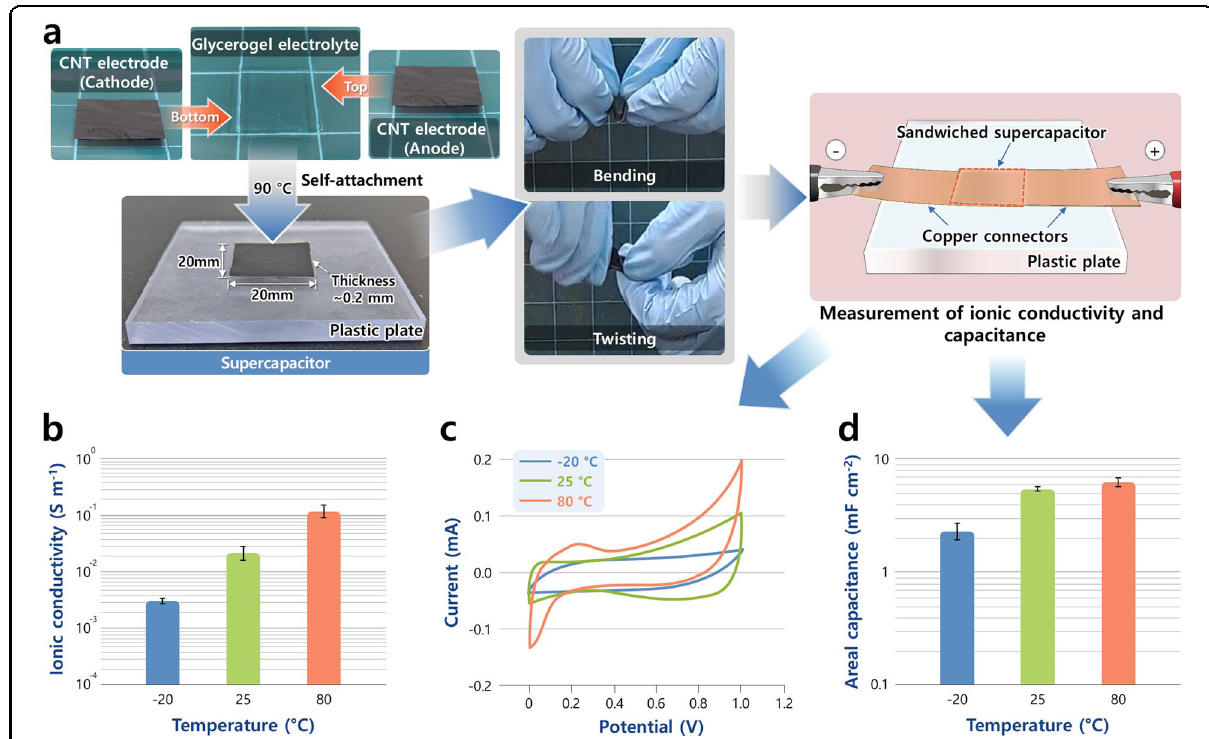
Fig. 6 GG-based fl exible electrolyte and supercapacitor. a Fabrication and characterization of the fl exible PVA-GG-electrolyte-based supercapacitor. b Ionic conductivities of the PVA GG electrolyte at different temperatures. c Cyclic voltammograms recorded at a scan rate of 1 mV s − 1 . d Calculated areal capacitance of the supercapacitor device measured at different